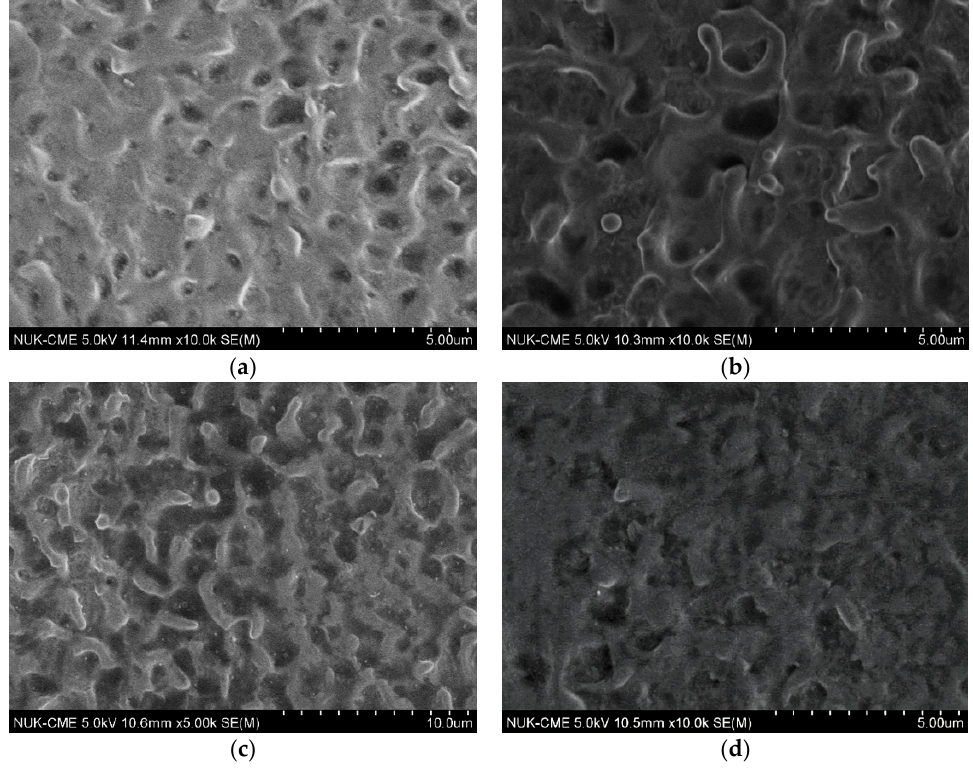
Figure 5. SEM at 10,000× when the applied voltage was ( a ) 180, ( b ) 220, ( c ) 260, and ( d ) 300 V, for the fixed electrode distance of 20 mm and cathodic specimen speed of 0.25 mm/s; NUK-CME: National University of Kaohsiung-Chemical and Materials Engineering.